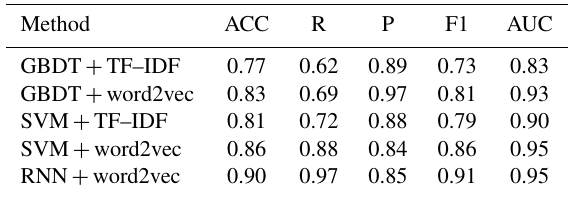
Table 5. Test set results of the SVM, GBDT, and RNN models.